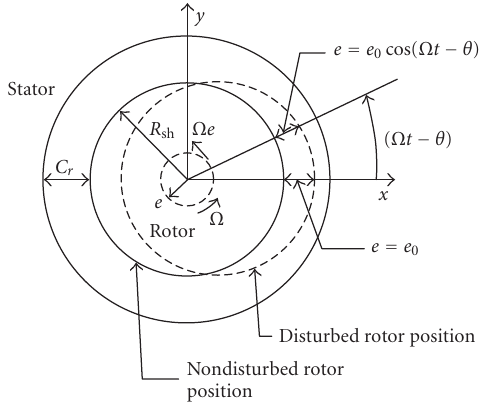
Figure 1: Geomatric and kinematic relationship of circular rotor whirl about the stator center at t = 0, ω : rotating speed; Ω whirling